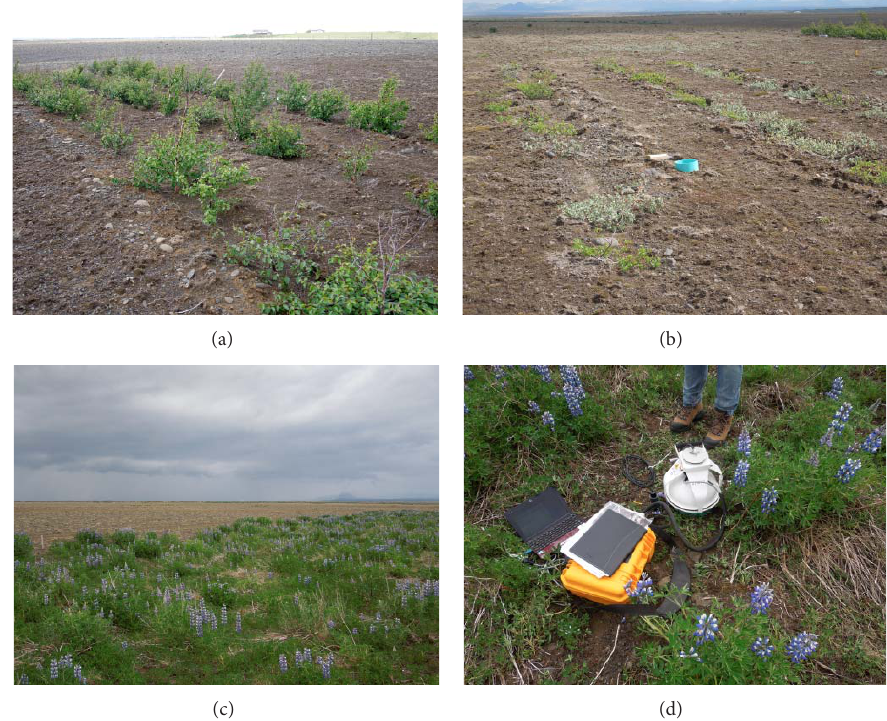
Figure 3: Views of grass-birch-willow and lupine-treated plots. (a) Rows of birch planted in plowed furrows surrounded by sparsely vegetated land surface originally seeded with grasses, but now largely covered by other native species (mainly crowberry) and BSC. (b) Willow and birch rows surrounded by BSC and other nongrasses. Soil collar is 20 cm in diameter. (c) Lupine-seeded plot presents highest biomass of all treatments. (d) Detail of area in (c) illustrates patchy distribution of lupine clusters with intervening open ground. Li-Cor soil gas analyzer system shown.